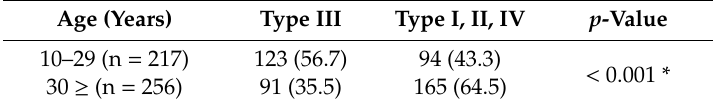
Table 3. Distribution of type III and other types (Type I, II, IV) according to the age group number